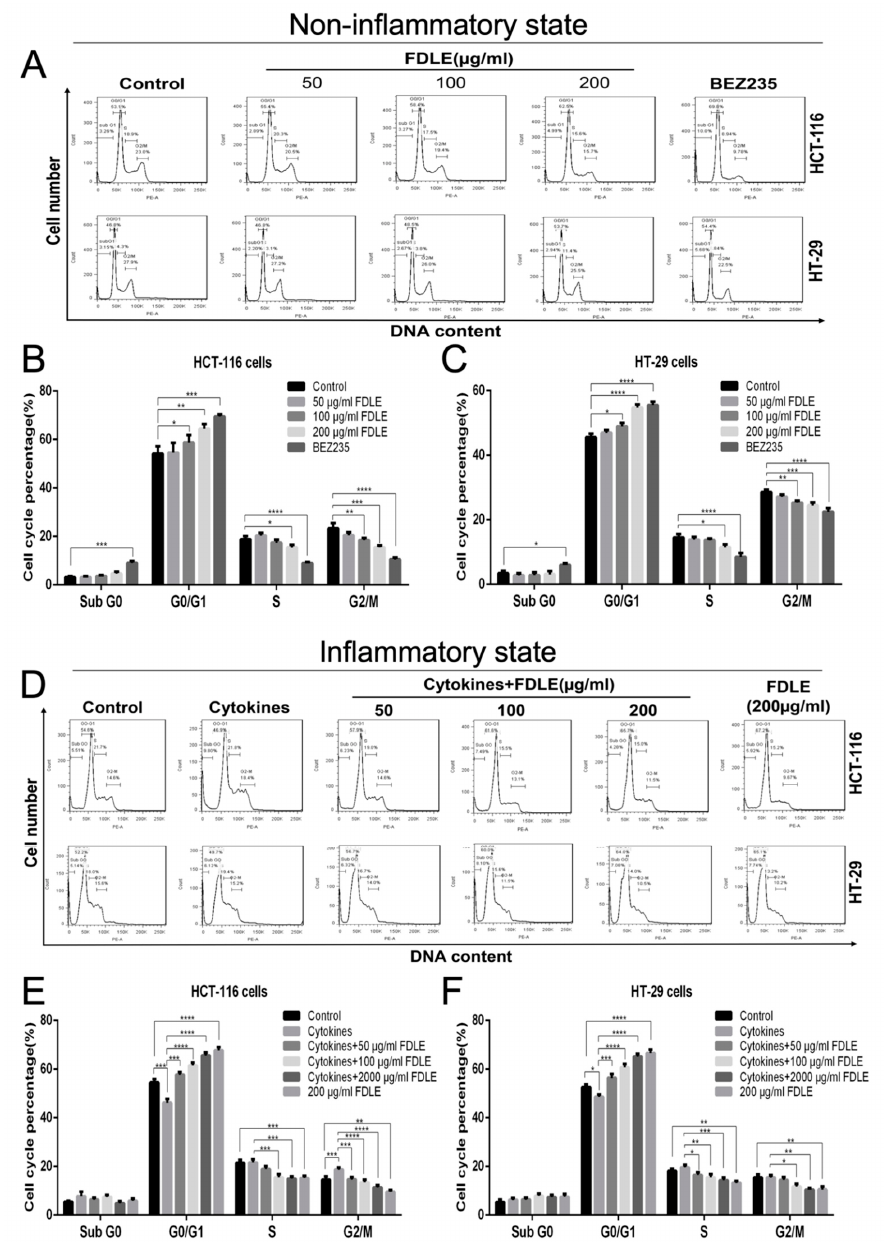
Figure 4. The effects of FDLE on cell cycle arrest in non-inflammatory and inflammatory HCT-116 and HT-29 colorectal cancer cells by flow cytometry. ( A – C ) Representative cell cycle distribution of non-inflammatory HCT-116 and HT-29 cells treated with three doses (50, 100 and 200 µ g/mL) of FDLE for 48 h. ( D – F ) Representative cell cycle distribution of inflammatory HCT-116 and HT-29 cells treated with three doses (50, 100 and 200 µ g/mL) of FDLE for 48 h after adding a mixture of cytokines (TNF- α , IFN- γ and LPS each 10 ng/mL) for 2 h. The results were represented as mean ± SD of